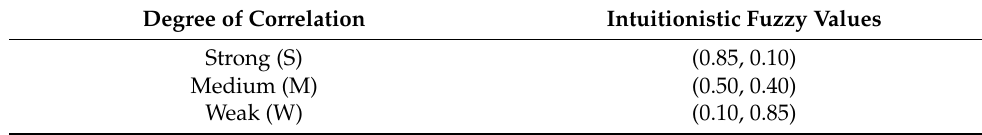
Table 4. Correlation degree between CRs and DRs and the corresponding fuzzy number.